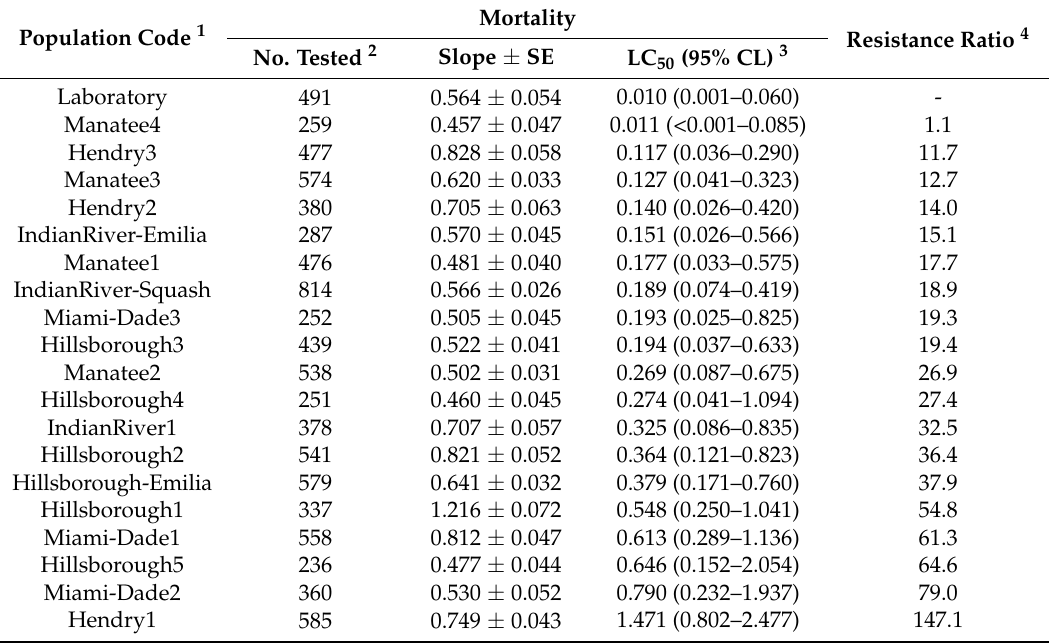
Table 4. Dose response to flupyradifurone and resistance ratios of Bemisia tabaci adults, reared from Florida field-collected populations, as measured by mortality (LC 50 ) with a cut cotton leaf and petiole systemic uptake bioassay in the